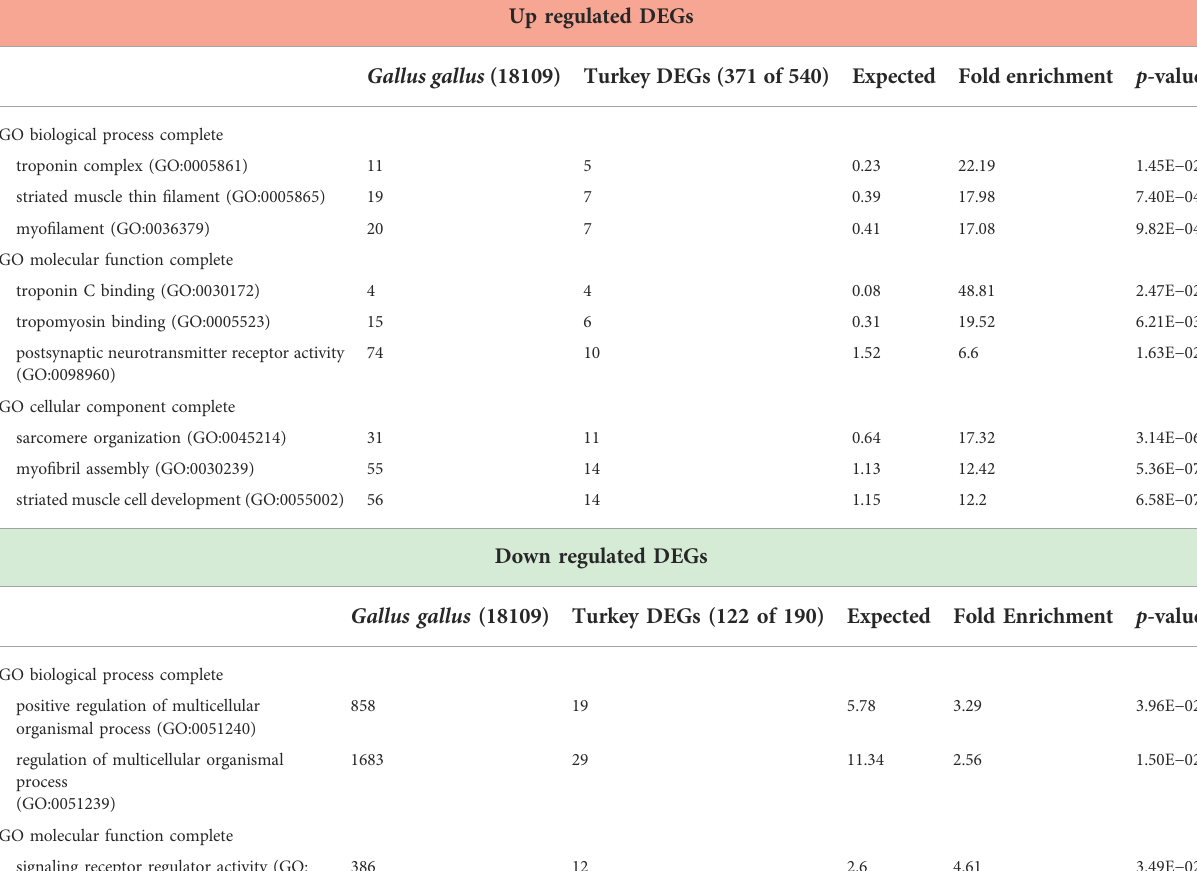
RYR3 (Figure 5), one of two sarcoplasmic reticulum calcium channel isoforms (the other being RYR1 ) expressed in skeletal